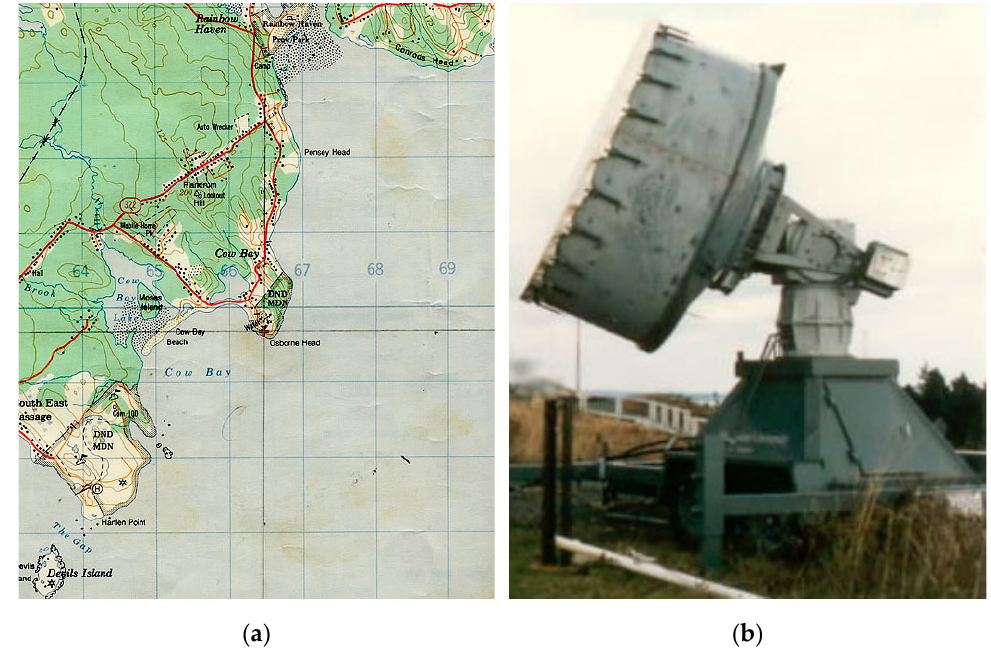
Figure 1. The collection location and a picture of the Intelligent Pixel Processing X-band (IPIX) radar. ( a ) Topo map of IPIX radar data collecting site in 1993, the latitude and longitude coordinates of the collection site are 44°36.72 ′ N and 63°25.41 ′ W, respectively; ( b ) IPIX radar picture. Table 1. Parameters of IPIX radar in 1993.